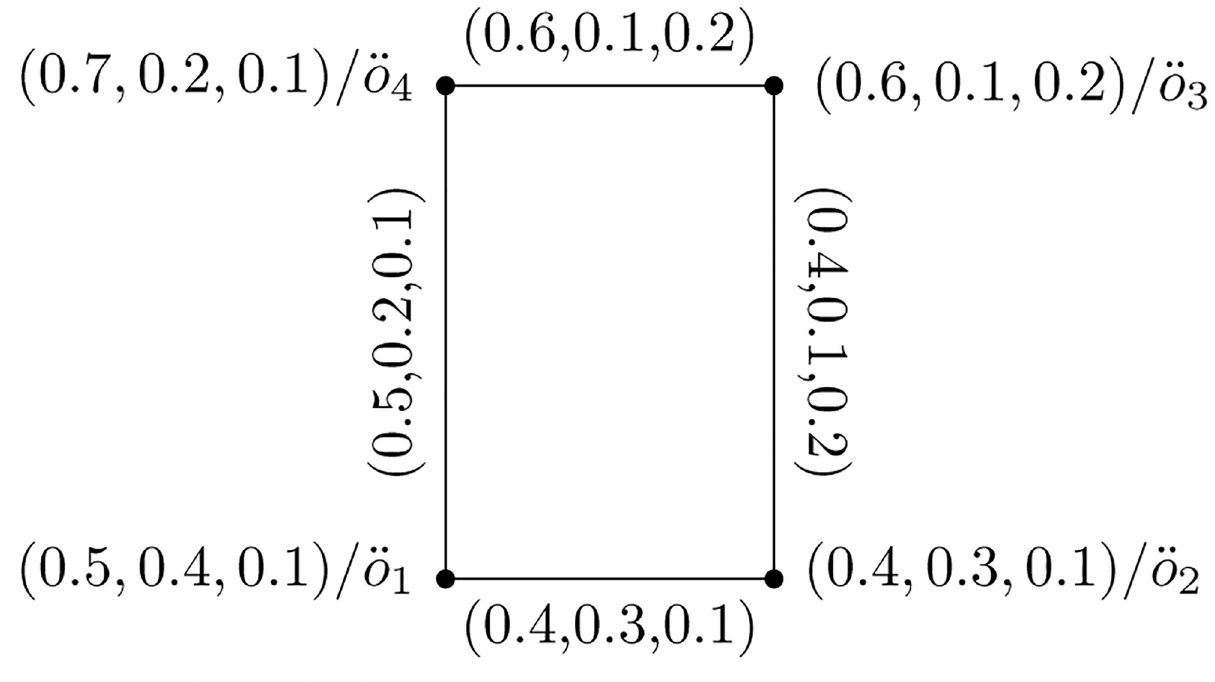
Fig 3. Strong picture fuzzy hypersoft